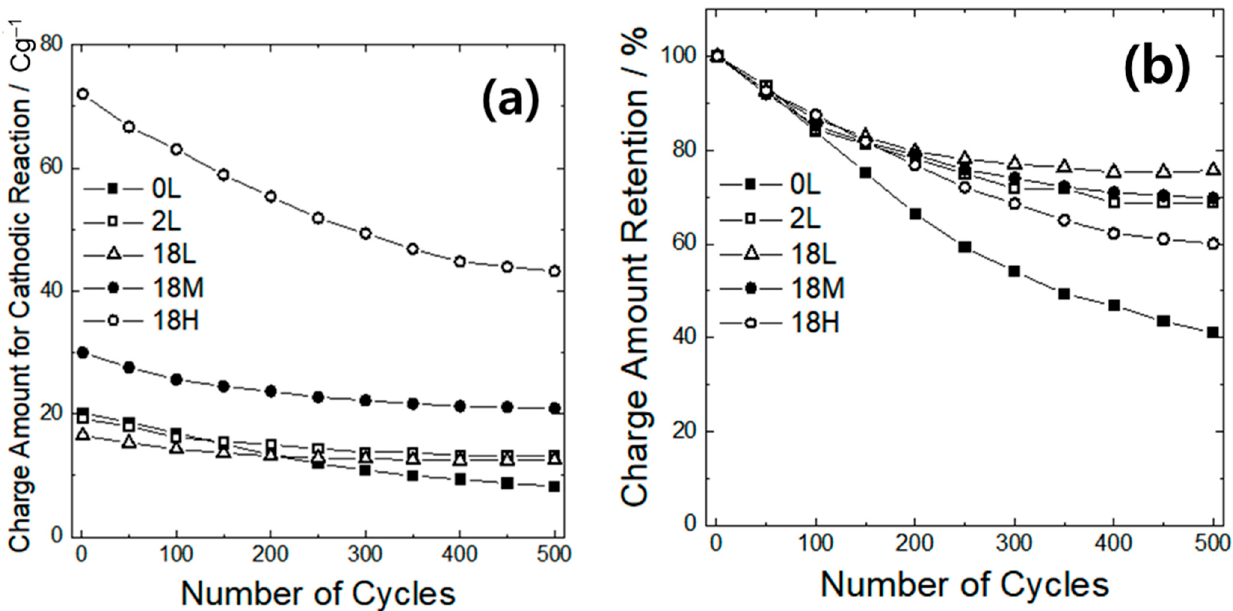
Figure 7. Variations of ( a ) the amount of cathodic charge amount and ( b ) charge amount retention with repetitive redox